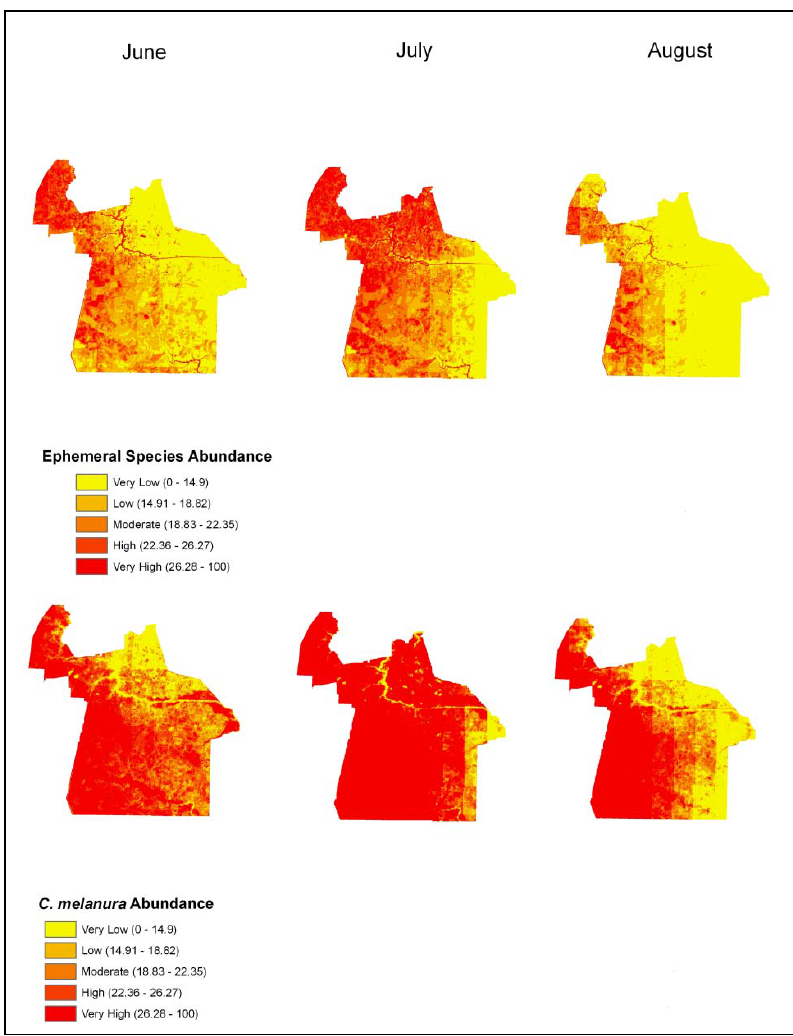
Figure 6. Monthly abundance of the ephemeral species for each month with values classified into